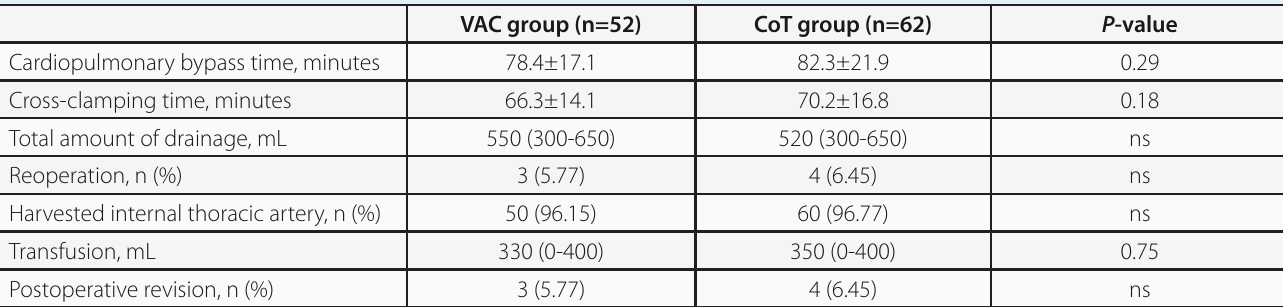
Table 2. Operative characteristics of the study population.